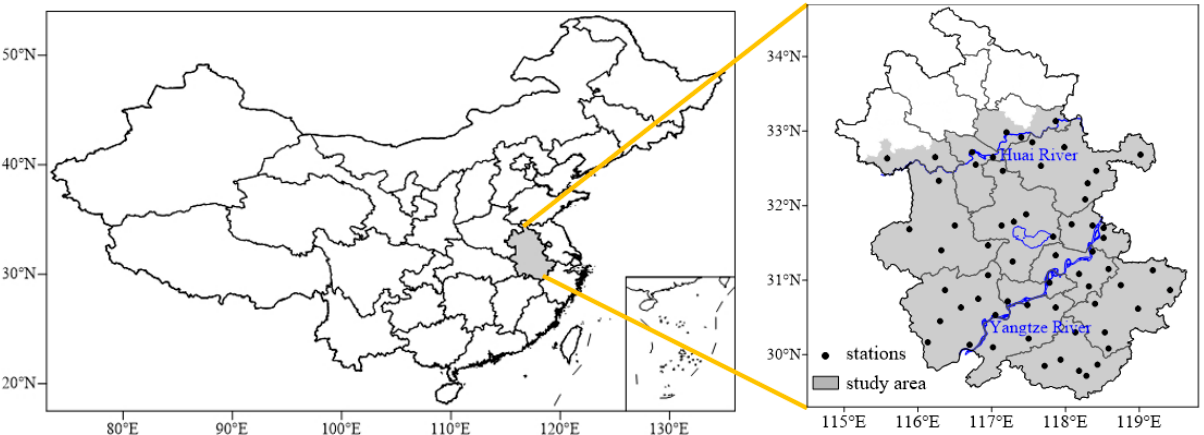
Figure 1. Location of observation stations over the area south of the Huai River of Anhui Province in China.